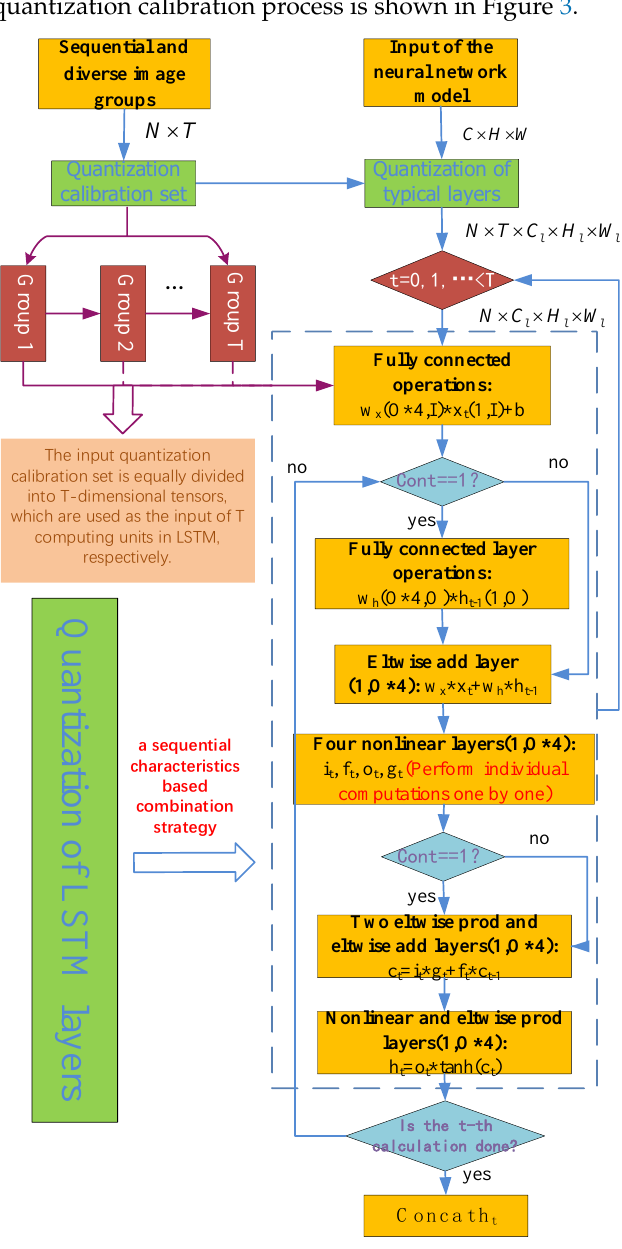
Figure 3. Quantization calibration process of LSTM layers. More precisely, when generating the quantization parameters, firstly all the N T groups data are sent to the regular layer, the activation quantization threshold is selected according to the output data distribution of this layer, and the data dimension of each layer l is N × T × C l × H l × W l . When the LSTM layer is encountered, according to the size of the time step T , the input quantization calibration set is equally divided into T tensors of dimension, which are, respectively, used as the input of the T computing units in the LSTM. Weights and activation quantization thresholds are selected layer by layer according to the weights and activation output distribution ranges for N sets of input data. Finally, the T output tensor sequences are combined into one output as the output of the LSTM layer. At this time, if there is still a regular layer after the LSTM layer, we continue to calibrate the N × T sets of output data to the subsequent layers.